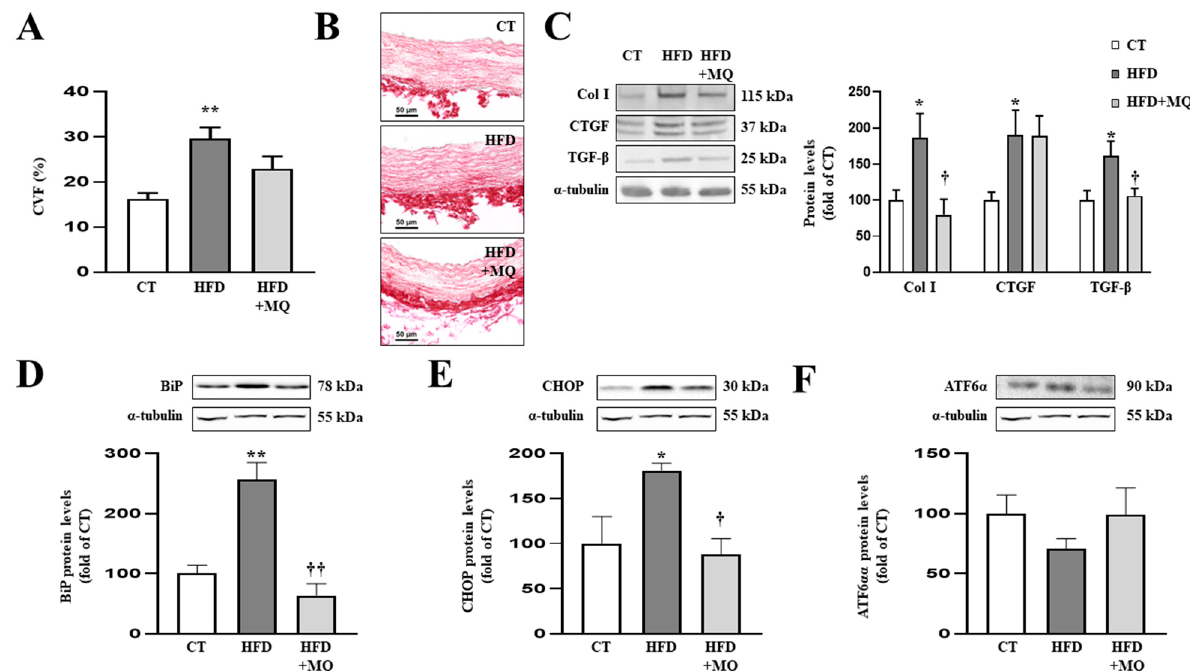
Figure 2. Mitochondrial oxidative stress mediates vascular fibrosis and endoplasmic reticulum stress at aortic level. ( A ) Quantification of collagen volume fraction and ( B ) representative microphotographs of aortic sections staining with picrosirius red. Protein levels of ( C ) collagen type I (Col I), connective tissue growth factor (CTGF) and transforming growth factor-beta (TGF- β ); ( D ) immunoglobulin binding protein (BiP); ( E ) CCAAT-enhancer-binding protein homologous protein (CHOP); ( F ) activating transcription factor 6-alpha (ATF6 α ) in aortic tissue from control rats fed a normal chow (CT) and rats fed a high-fat diet (HFD) treated with vehicle or with the mitochondrial antioxidant MitoQ (MQ; 200 µ M). Scale bar: 50 µm. Bars graphs represent the mean ± SEM of 6–8 animals normalized for α -tubulin. * p < 0.05, ** p < 0.01 vs. control group. † p < 0.05, †† p < 0.01 vs. HFD group.